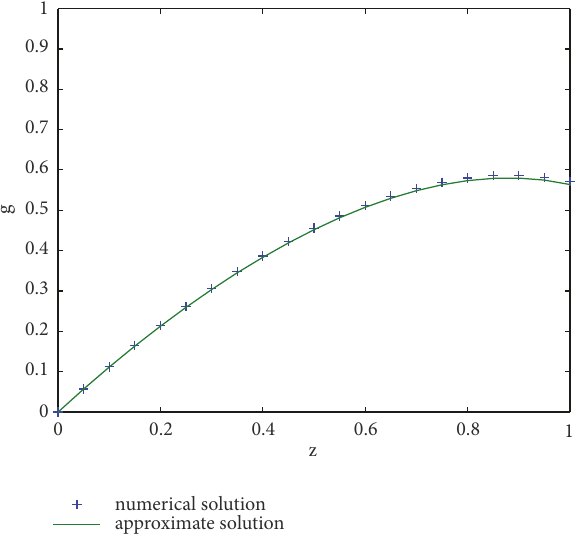
Figure 11: The comparison of the results of approximate solution and numerical solution for 𝛼 = 10.0 , 𝑛 = 1.0 , 𝑘(𝑧) = 𝑧 , ℎ(𝑧) = (1 − 𝑧) 2